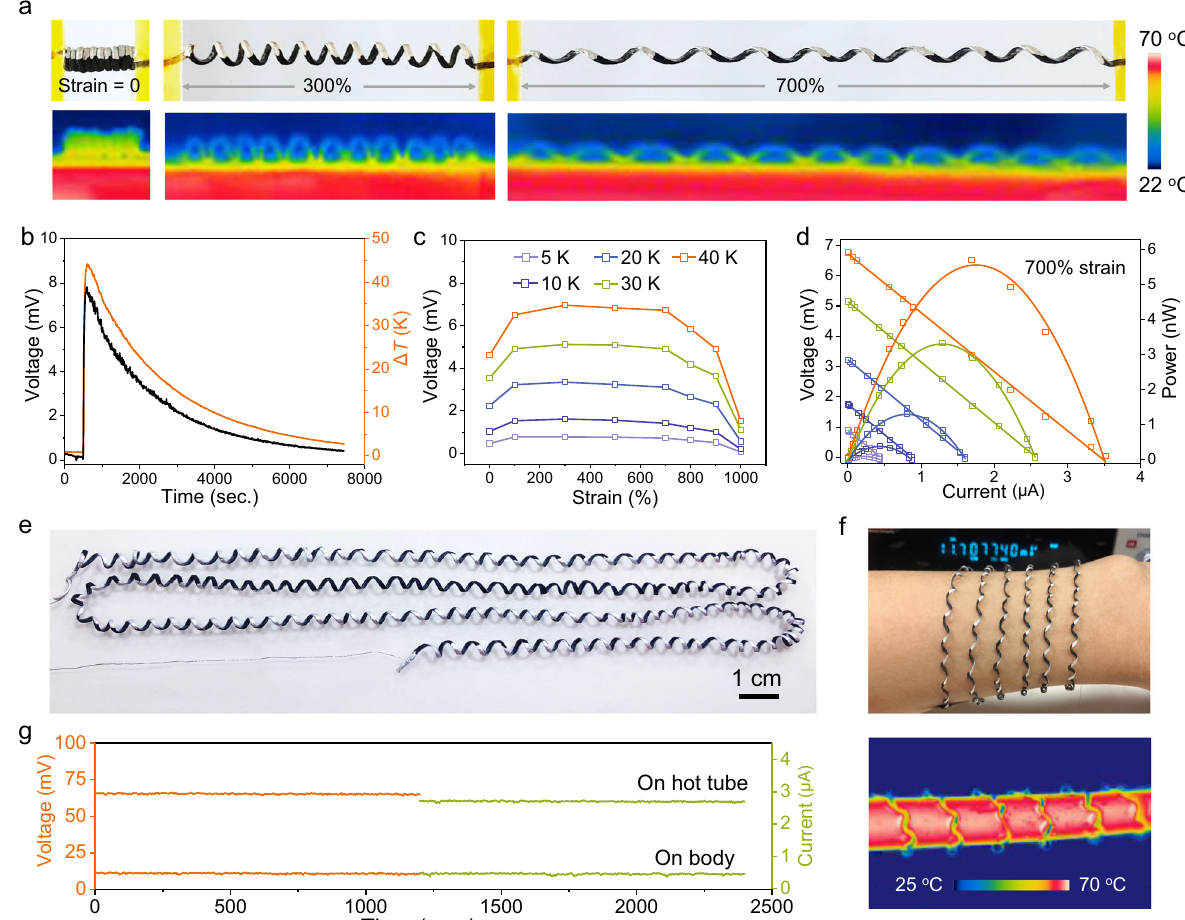
Fig. 6 Utilization of Janus hydrogel spring as a stretchable and compliant thermal energy harvester. a Photographs and infrared images of the Janus spring at different strains and a temperature difference of 40 °C between the hot substrate and ambient air. b V oc of the Janus spring varies the temperature difference over with time. c V oc at different strains and temperature difference. d TE performance at 700% strain of different temperature difference. e Photograph of a Janus hydrogel spring composed of >100 TE coils electrically connected in series. f Photograph of a wearable TE bracelet (top) and infrared image of a coilable TE (bottom). g V oc and I sc of the TE bracelet and